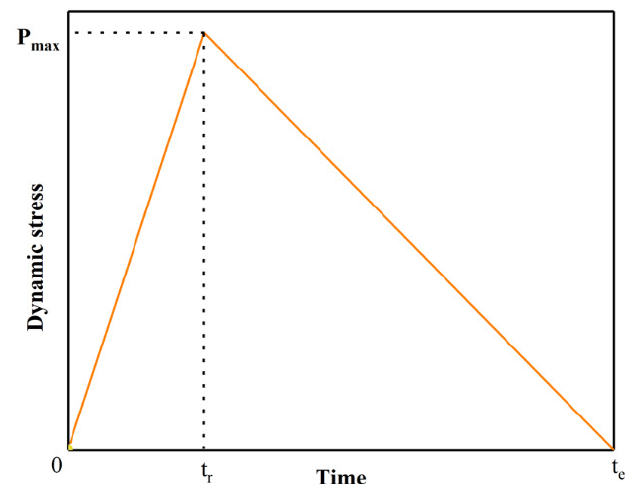
Figure 6. Triangular load.